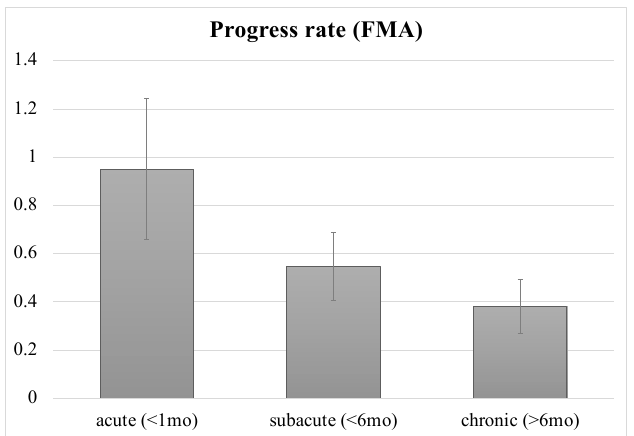
Figure 2. Progress rate of patients at acute, subacute and chronic phases. Error bars indicate standard errors. There were no significant differences, only a trend, among the three phases. FMA: Fugl-Meyer motor assessment scale for upper extremity; mo: month.